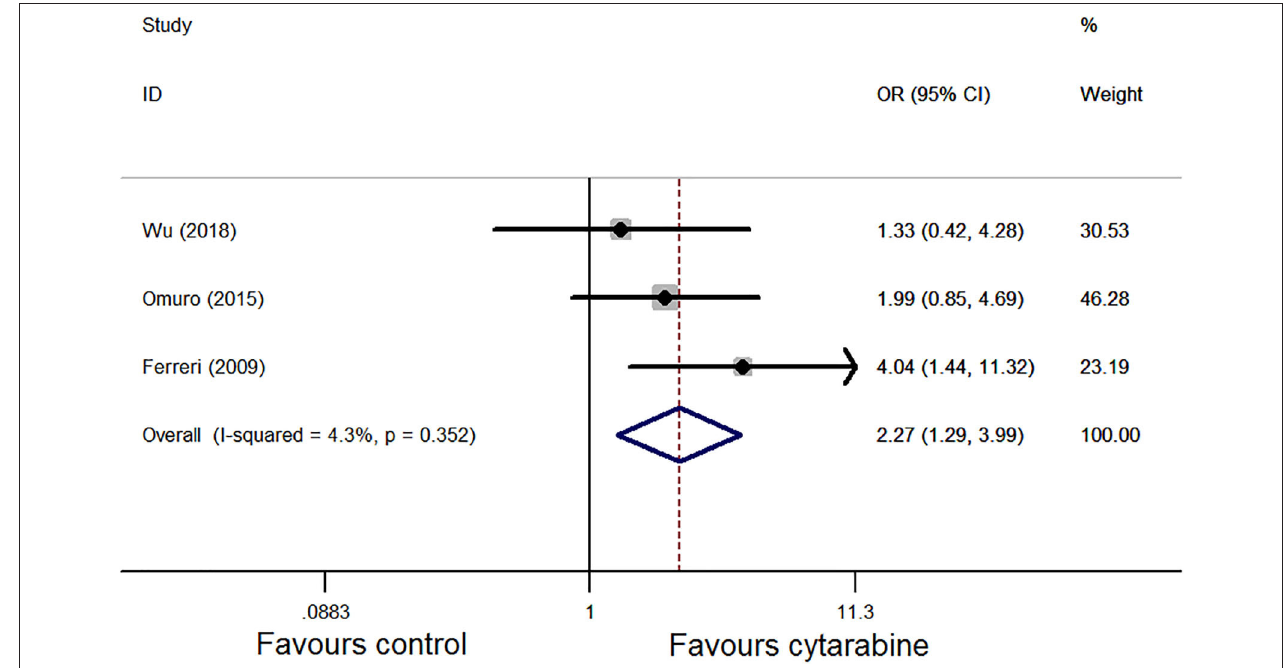
FIGURE 2 | Forest plot of the complete remission for treatment with the cytarabine group vs. cytarabine-free group (fixed effect model). OR is the effect size.